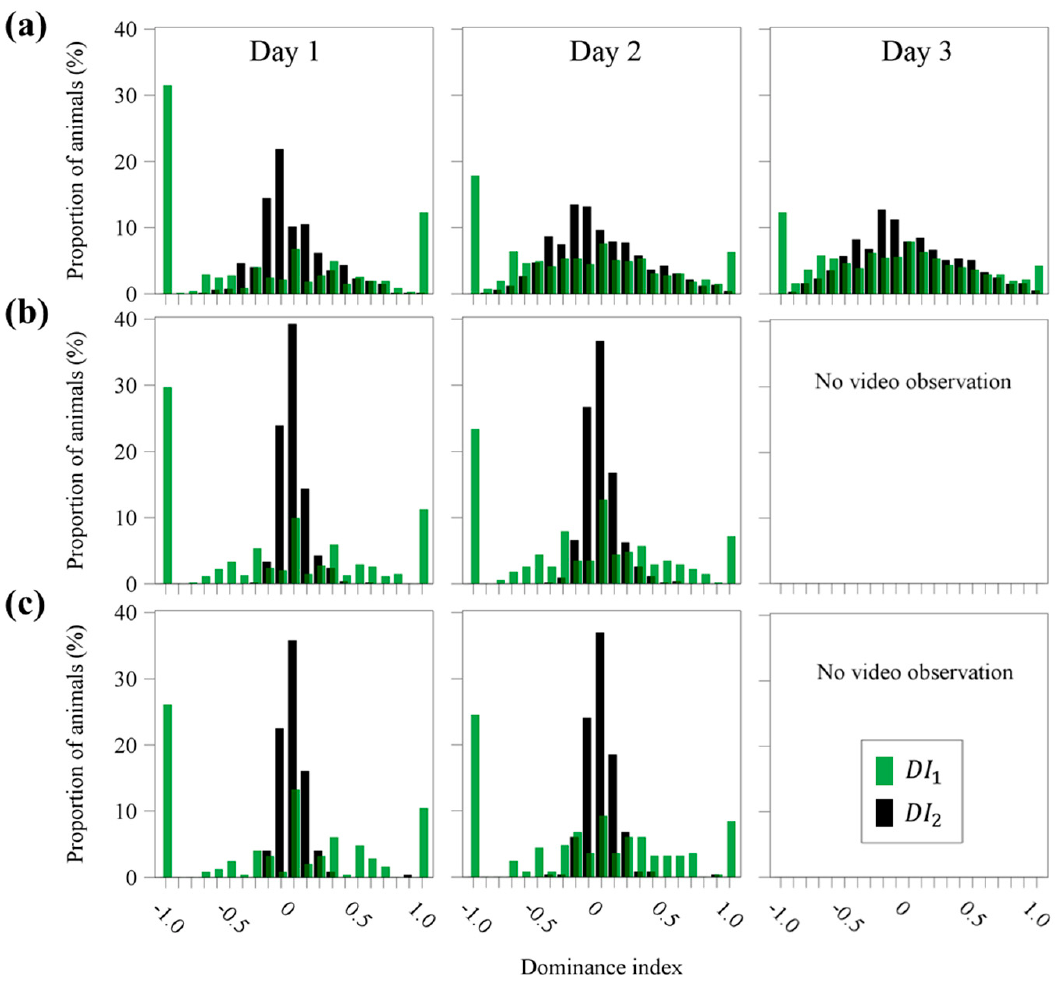
Figure 2. Frequency distributions of the dominance indices ( DI 1 and DI 2 ) for the three age groups (( a ) weaned piglets, ( b ) fattening pigs, ( c ) gilts) after 1, 2 or 3 days of video observation.